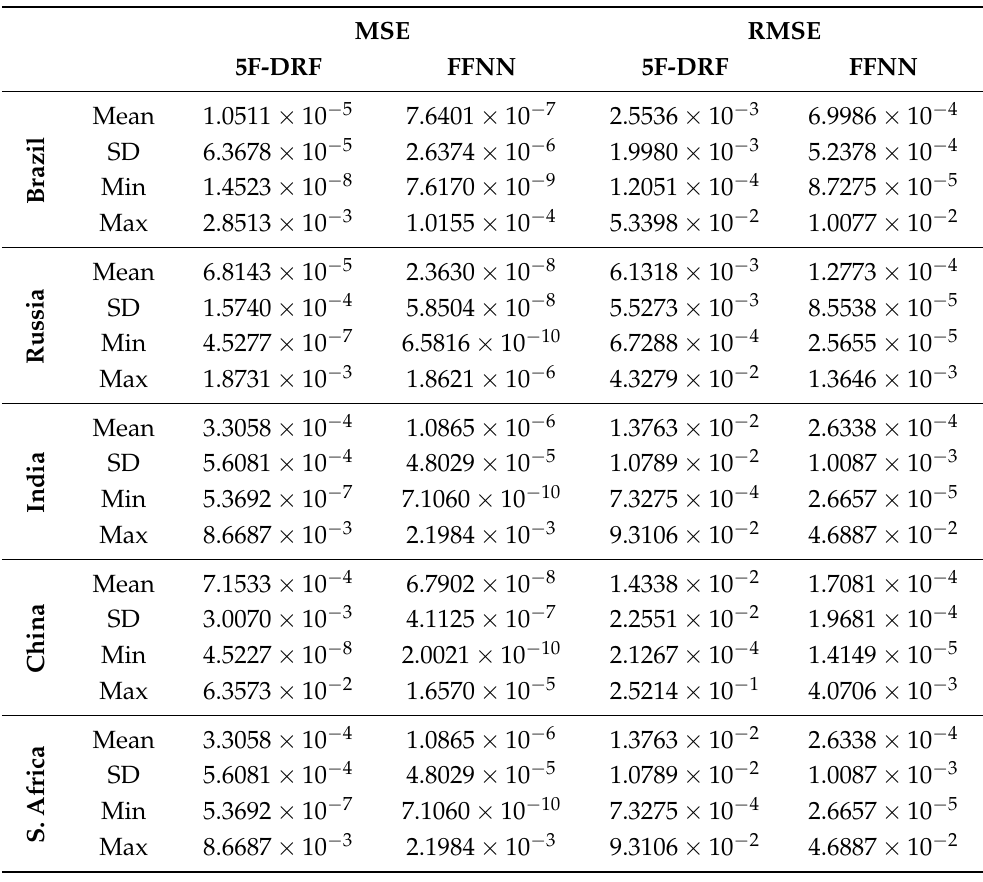
Table 4. Main statistics for MSE and RMSE associated to 5F-DRF and FFNN models applied to the BRICS